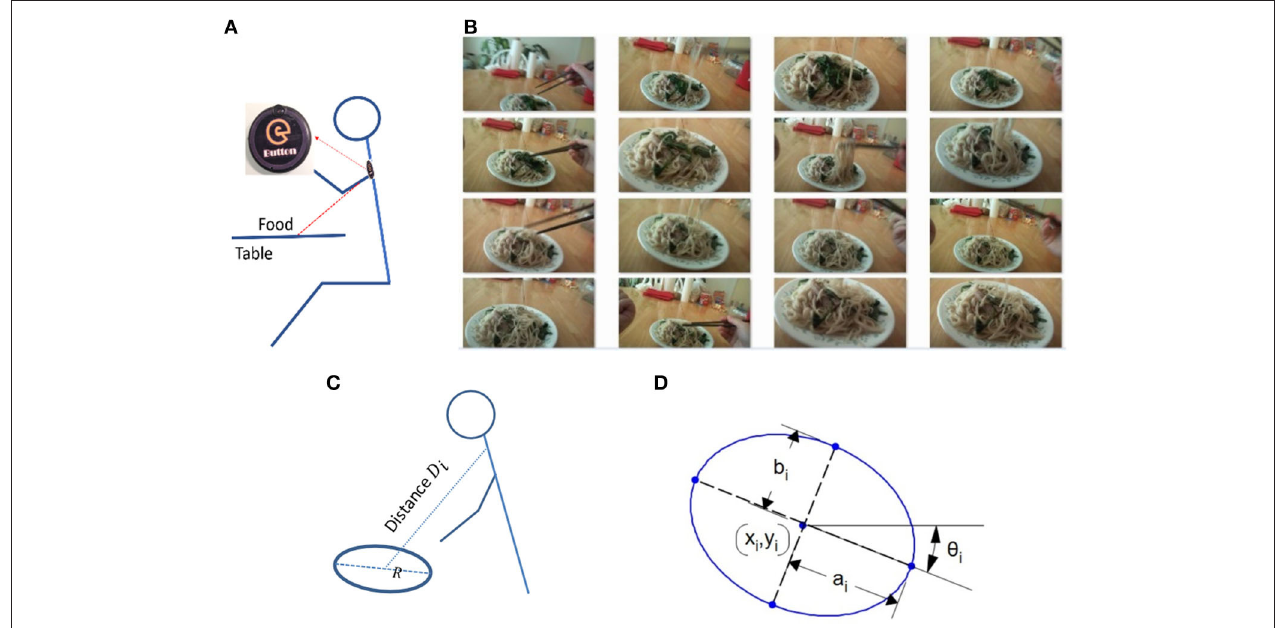
FIGURE 1 | (A) A skeletal representation of a person wearing eButton during a meal; (B) Part of an egocentric image sequence acquired by the eButton showing quasiperiodic variations of the ellipses of the plate; (C) Definition of D i ; (D) Parameters of an